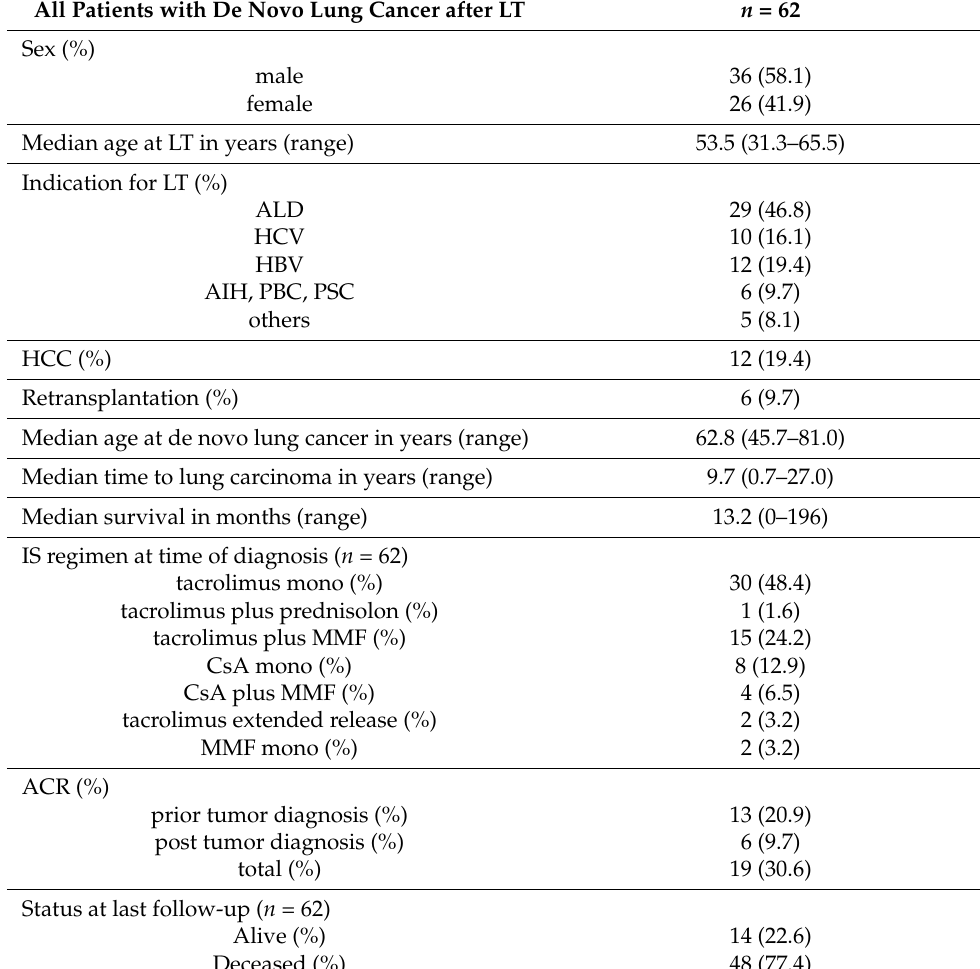
Table 1. Patient